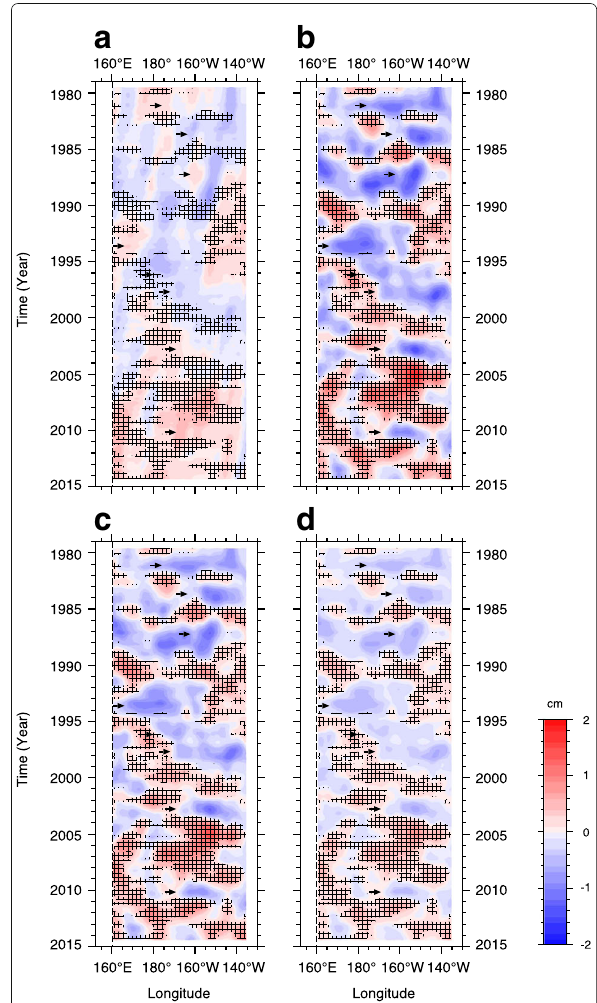
Fig. 16 Hovmöller diagrams of SSH (cm) at the latitude of station K2 (47° N) due to the a first ( n = 1), b second ( n = 2), c third ( n = 3), and d fourth ( n = 4) baroclinic Rossby wave modes forced by the wind stress. Arrows indicate El Niño-related SSH depressions shown in Fig. 14 b. Meshing denotes Ekman vertical velocity anomaly from the mean value at each longitude smaller than − 0.2 × 10 − 6 ms − 1 . The vertical dashed lines indicate the longitude of station K2 (160°